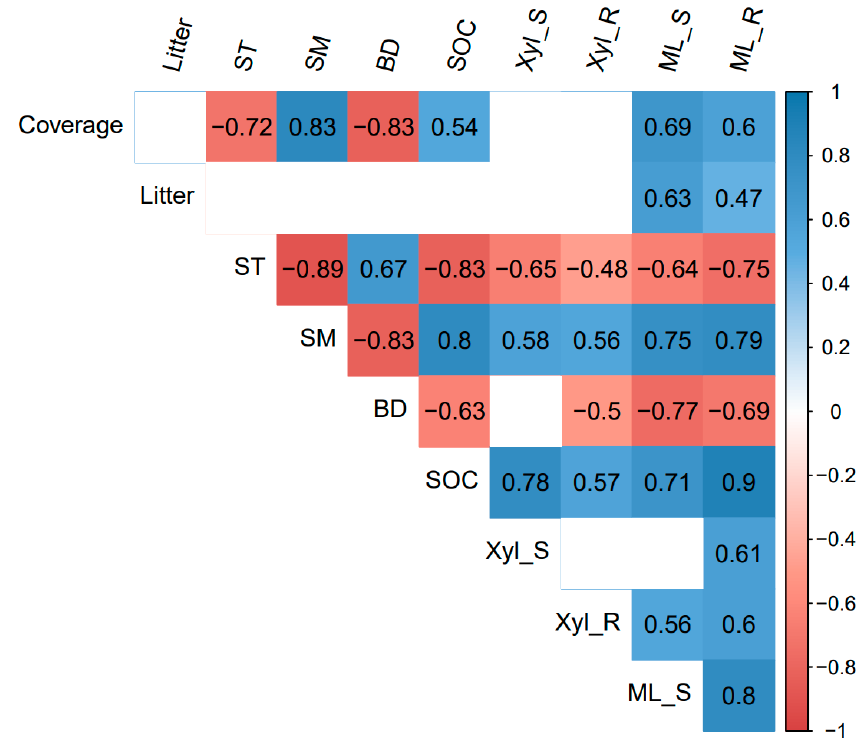
Figure 3. Heatmap of Pearson correlation between 10 variables. Litter: litter biomass; ST: Soil temper- ature; SM: Soil moisture; BD: bulk density; SOC: soil organic carbon; Xyl_S: β -xylosidase of shoot; Xyl_R: β -xylosidase of root; ML_S: mass loss of shoot; ML_R: mass loss of root. HG: high altitude + grazing; HM: high altitude + mowing; LG: low altitude + grazing; LM: low altitude + mowing. p -value set at 0.05 for significance.